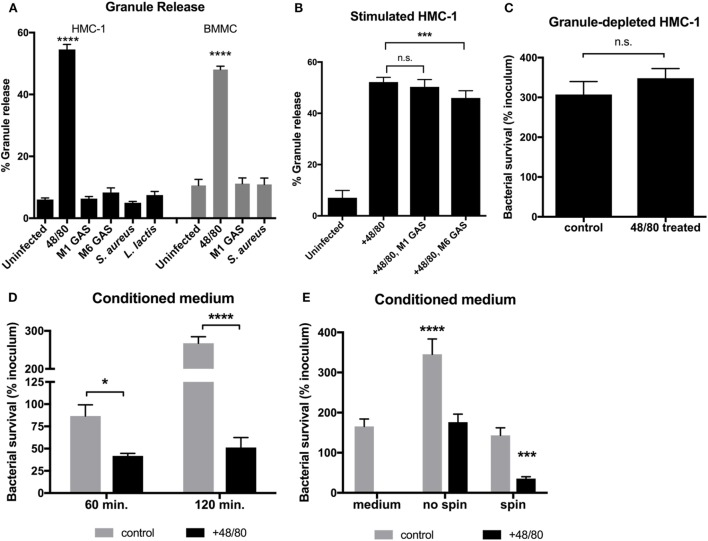
Granule release is necessary for MCs to effectively kill group A Streptococcus (GAS). (A) Beta-hexosaminidase granule release assay with HMC-1 cells (solid bars) or bone marrow-derived MC (shaded bars) incubated with the indicated strains. (B) Beta-hexosaminidase granule release assay with compound 48/80-treated HMC-1 cells incubated with the indicated strains. For statistical analysis, data were compared to granule release from uninfected cells (A) or 48/80-treated cells (B). (C) GAS growth with untreated (control) or granule-depleted HMC-1 cells (cells treated with compound 48/80 and washed to remove released granules). (D,E) GAS survival with supernatant collected from untreated (control) or compound 48/80-treated HMC-1 cells (conditioned medium). In panel (E), GAS and supernatants were centrifuged or not as indicated prior to incubation. For statistical analysis, data was compared to GAS grown in control supernatants (D) or medium alone (E). For all panels, data from at least three independent experiments were combined, results are given in average ± SEM and analyzed by one-way ANOVA with Sidak’s multiple post-test (****P < 0.0001, ***P < 0.001, *P < 0.05, n.s., not significant).